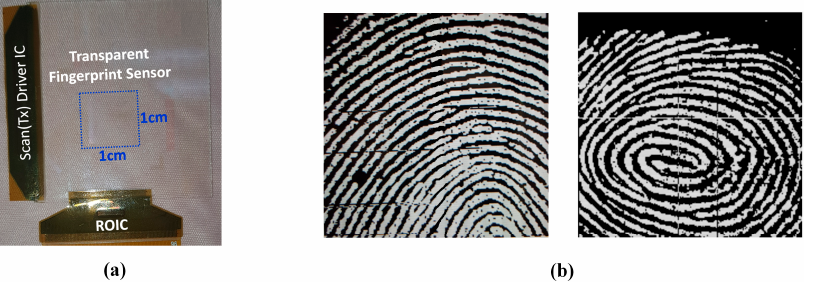
Figure 11. ( a ) The assembled module of the transparent fingerprint sensing system. ROIC is packaged on COF (chip-on-film) and attached to the panel; ( b ) measured fingerprint image with pores.